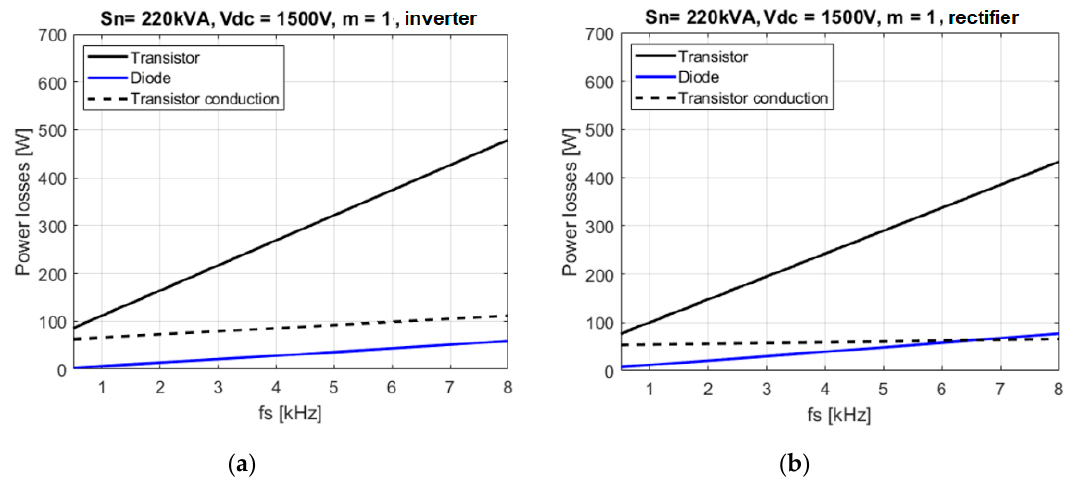
Figure 3. Power losses vs. switching frequency for inverter mode ( a ) and rectifier mode ( b )—an estimation for a 220 kVA inverter.